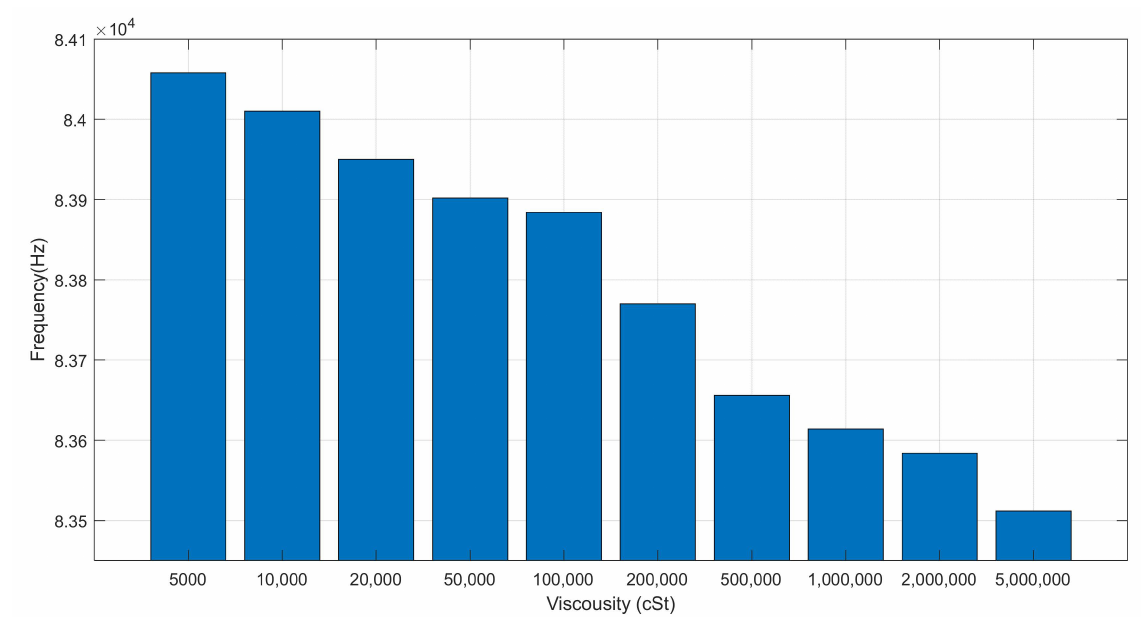
Figure 13. Impedance real part resistance of damping fluid with different viscosity.